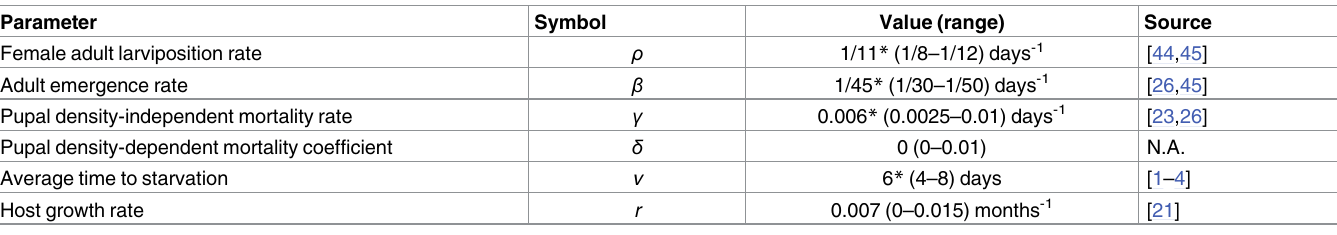
Table 1. Model parameter